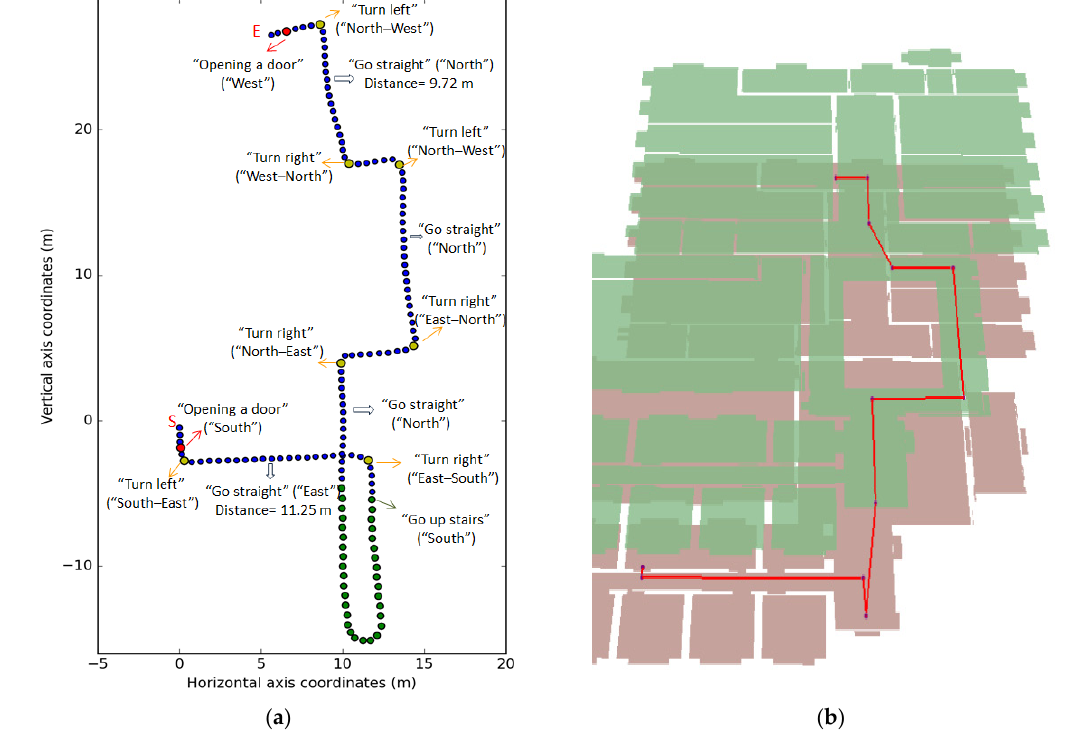
Figure 9. Semantic matching result. ( a ) The raw trajectory and semantics; ( b ) The matched trajectory.